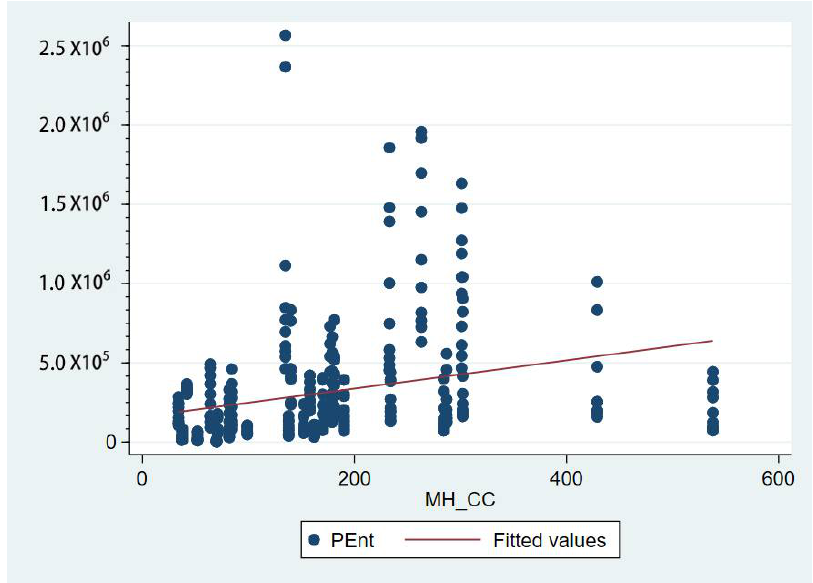
Figure 2. Relationship between cultural sites and entrepreneurship. Source: China Statistical Yearbooks, China Economic Census Yearbook and the website of Chinese Intangible Cultural Heritage.